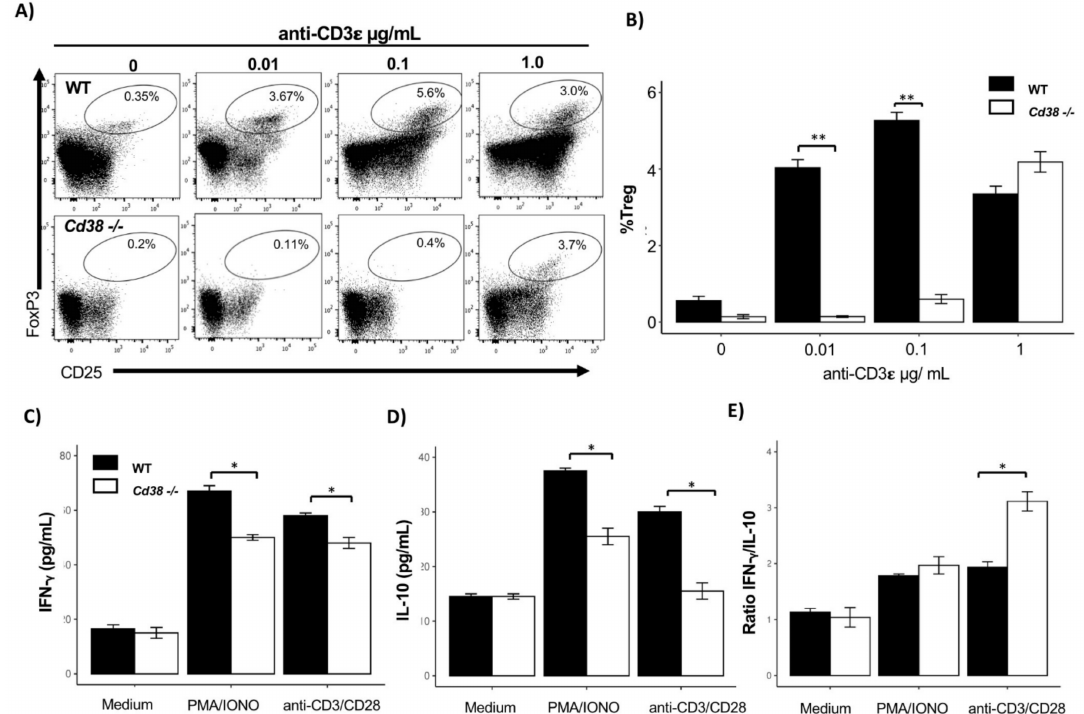
Figure 5. Reduced Treg expansion and IL-10 secretion in stimulated CD38-/- splenocytes. Splenocytes from WT ( n = 3) and CD38-/- ( n = 3) were left unstimulated or stimulated with indicated concentrations of anti-CD3 for 72 h. Cells were stained with anti-CD4 and anti-CD25, followed by intracellular staining for Foxp3. ( A ) Representative dot plots of Treg gated according to CD25 and FoxP3 expression. Numbers in the oval indicate the percentage of Treg cells after stimulation; ( B ) percentage (mean ± SEM) of Treg cells obtained from the culture; ( C ) concentrations (mean ± SEM) of IFN- γ and ( D ) IL-10 release in splenocyte-culture supernatant upon in vitro stimulation with anti-CD3/CD28 + rhIL-2 for 72 h; ( E ) IFN- γ /IL-10 ratio. Statistical analysis was performed using two-way ANOVA followed by Tukey test, where ** p < 0.001, and * p <